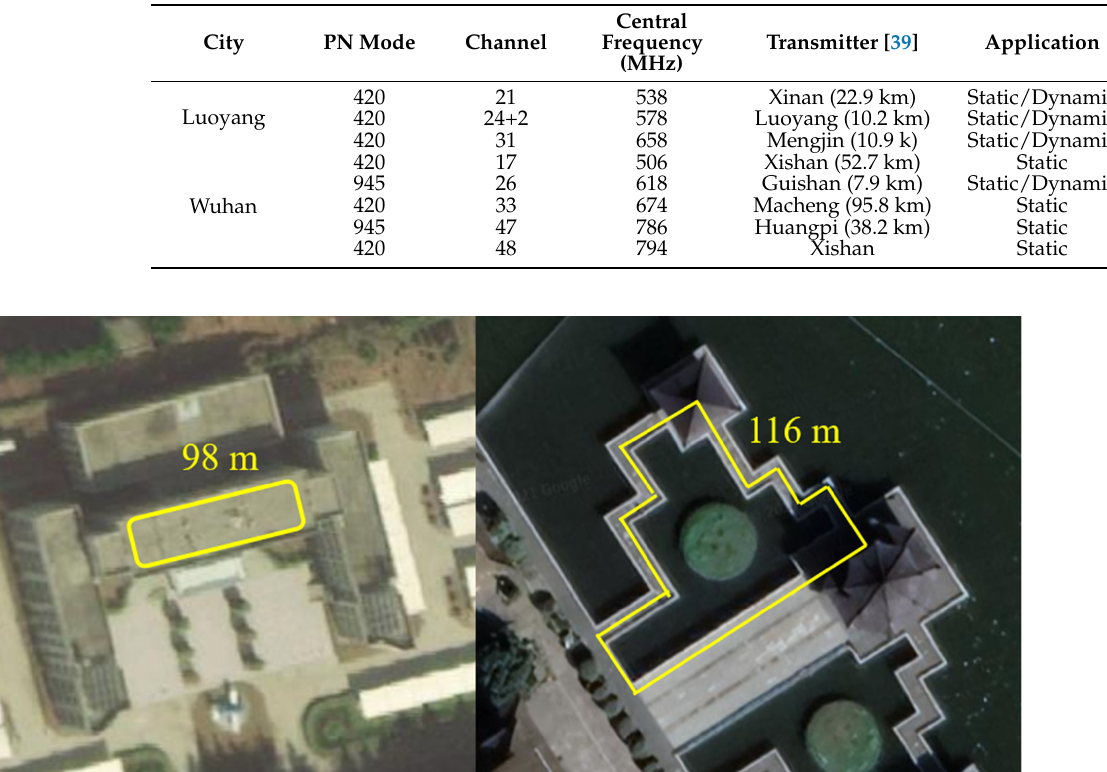
Table 1. Receiving details of the signal channel in field tests.